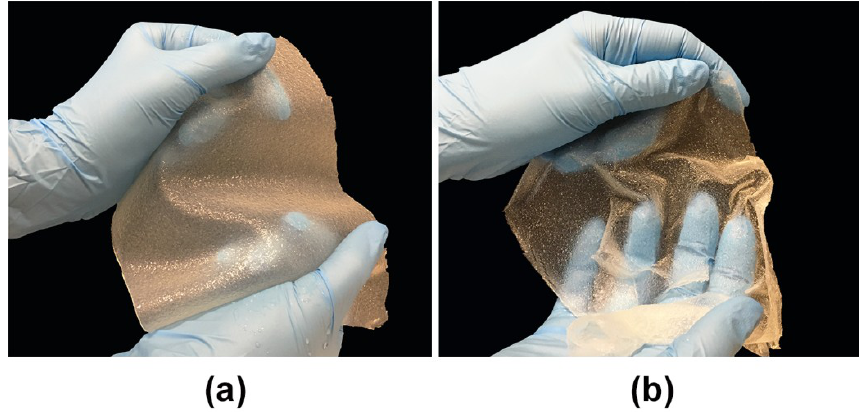
Figure 1. Images presenting fabricated chitosan/agarose (CHN/A) films: ( a ) CHN/A film in a wet state with a thickness of 2.12 mm (potential dermal skin graft); ( b ) CHN/A film in a wet state with a thickness of 0.15 mm (potential epidermal skin graft).